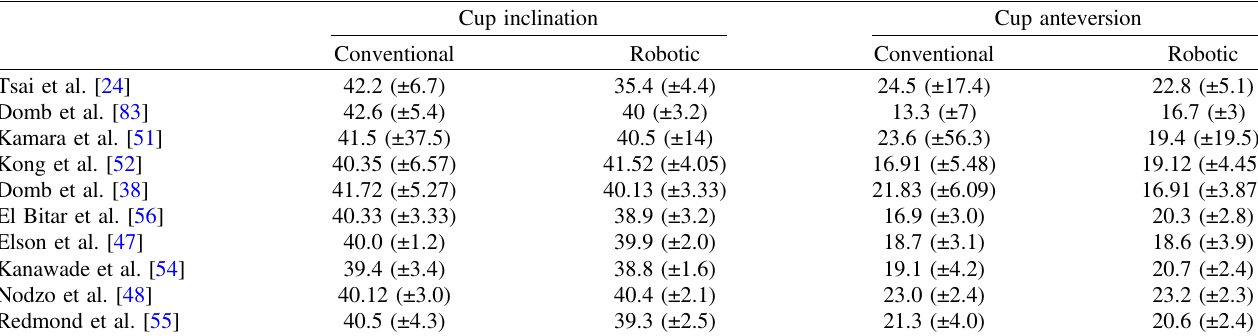
Table 2. Demographic characteristics, follow-up and complications of reported main studies on robotic-assisted THA studies. Cup inclination Cup anteversion Conventional Robotic